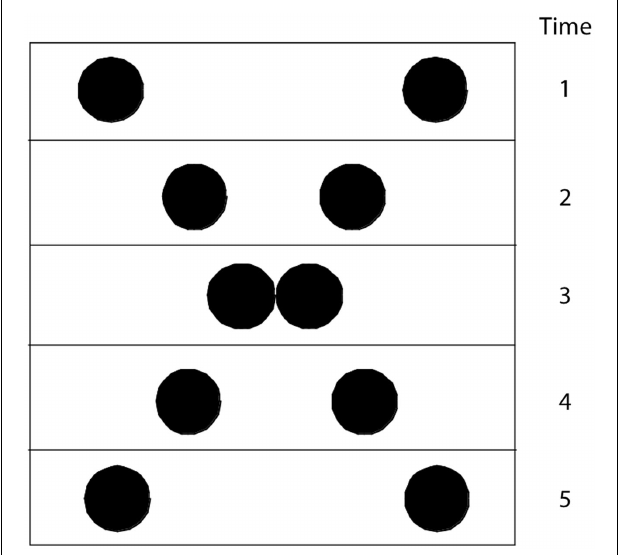
FIGURE 2 | Five frames of an ambiguous apparent motion sequence. Two balls can be either seen passing through each other or as bouncing off one